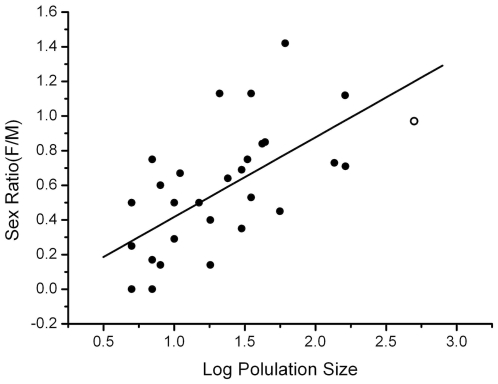
Correlation of log population size and sex ratio (F/M) of 30 populations on the fragmented islands (closed circle) and one population on the mainland (open circle), The Pearson correlation coefficient r = 0.661, p<0.001.